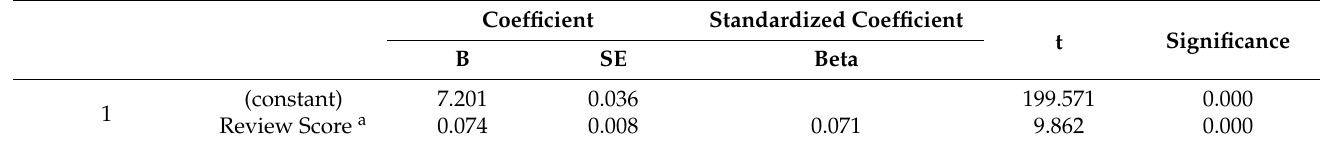
Table 12. Results of Test 4.